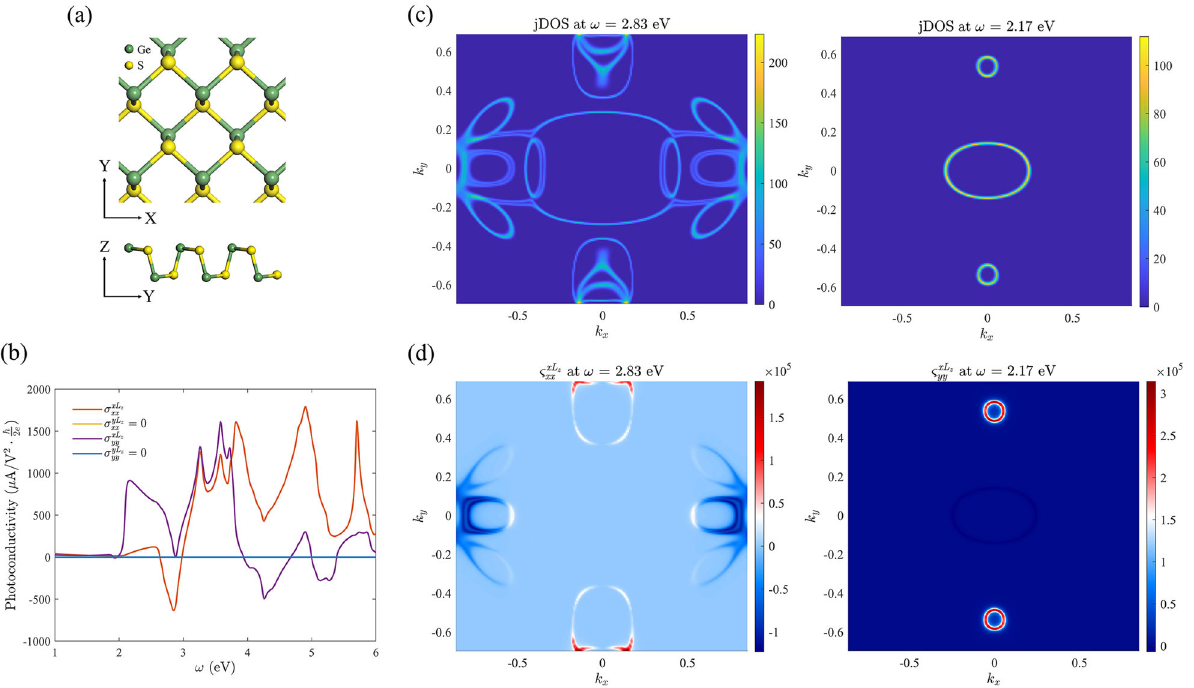
Fig. 2 BOPV response of monolayer GeS. a Atomic geometry of monolayer GeS. b Calculated BOPV conductivity as a function of incident linearly polarized light frequency. c jDOS ~ ρ ð ω ; k Þ distribution in the fi rst BZ at ω ¼ 2 : 83eV and ω ¼ 2 : 17eV . d k -resolved BOPV conductivity ς x ; L z ð k Þ (at ω ¼ 2 : 83eV ) and ς x ; L z ð k Þ (at ω ¼ 2 : 17eV xx yy